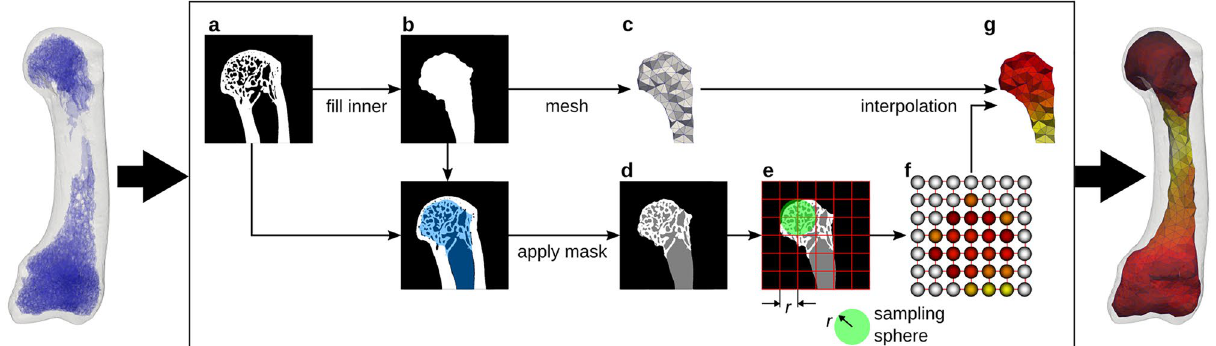
Figure 1. Mapping of morphometric quantities of trabecular bone onto finite-element meshes using the HMA method. The schematic overview shows the required image processing steps for a 2D slice, although the principle is similar in 3D. Original segmented µ CT image ( a ). Trabecular mask ( b ). Mesh generated from trabecular mask ( c ). Masked trabecular volume ( d ). Evaluation of morphometric quantity using background grid with grid distance r and sampling sphere with radius r ( e ). Evaluated quantity at the background grid vertices (spheres not to scale) ( f ). Linear interpolated quantity on the mesh ( g ).